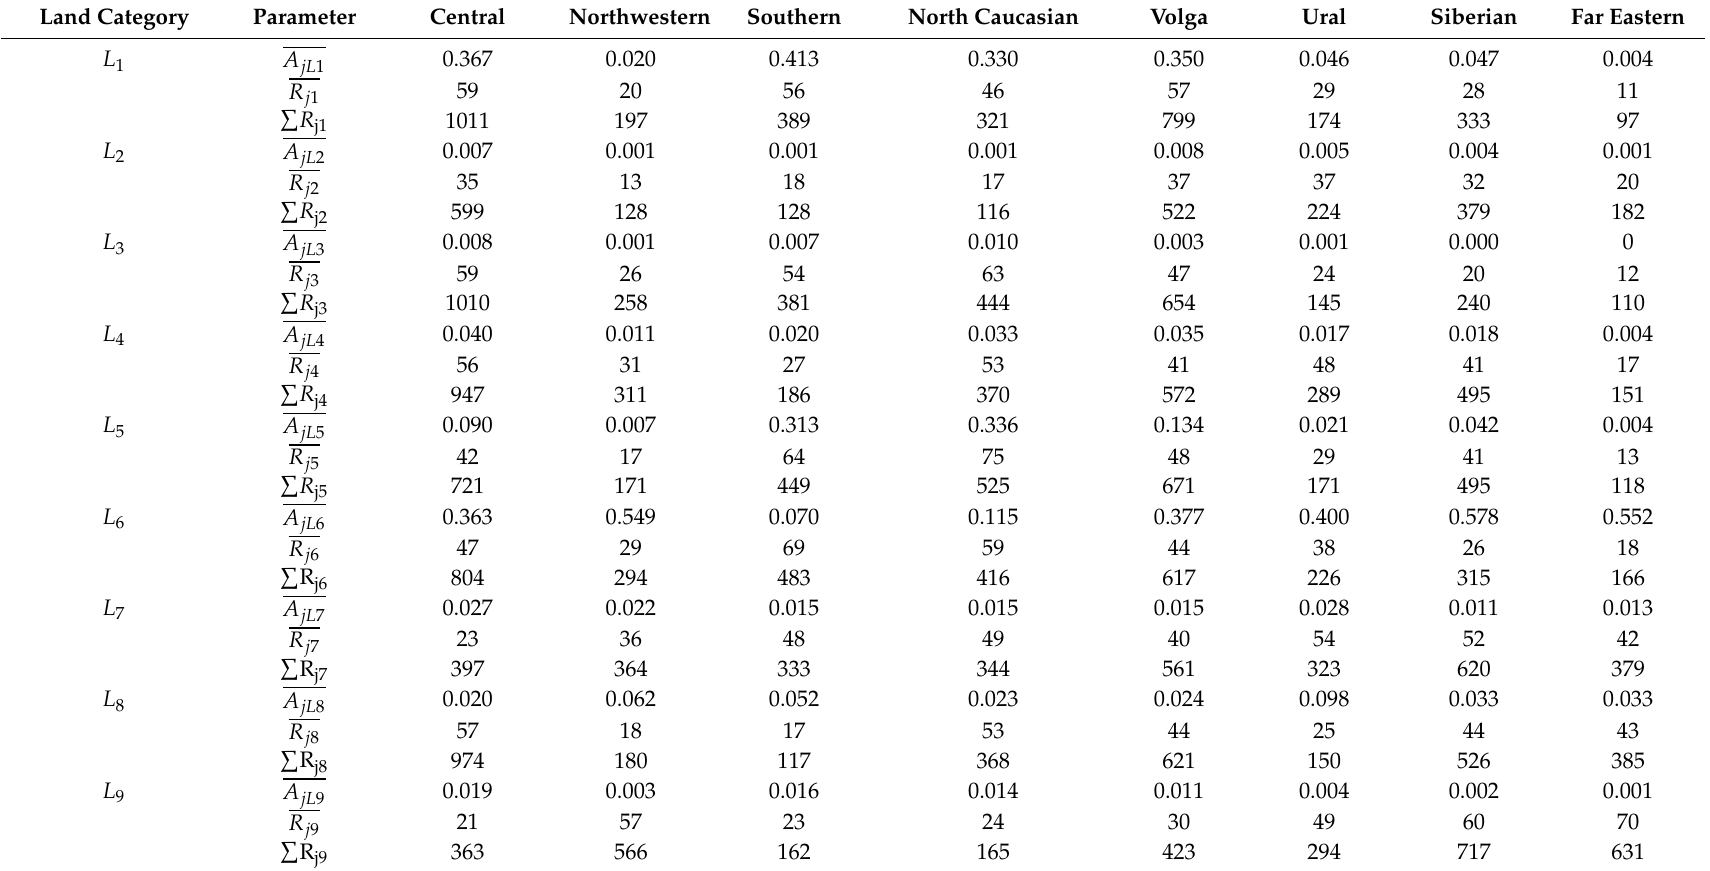
Table A25. Ranking of T j territories on a parameter of agricultural land activity, federal districts